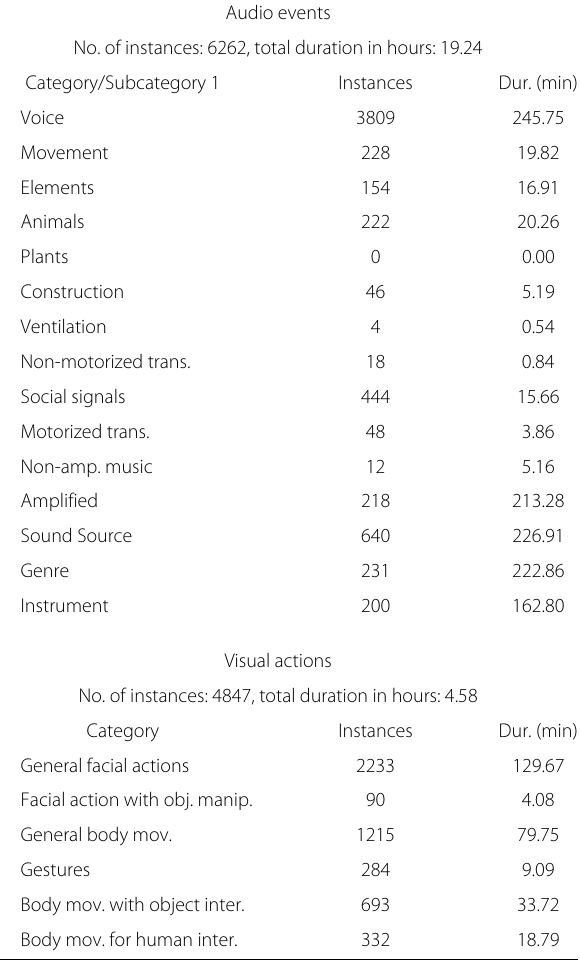
Table 6 Statistics for COGNIMUSE database (Hollywood movies and GWW) annotated with audio-visual events per event